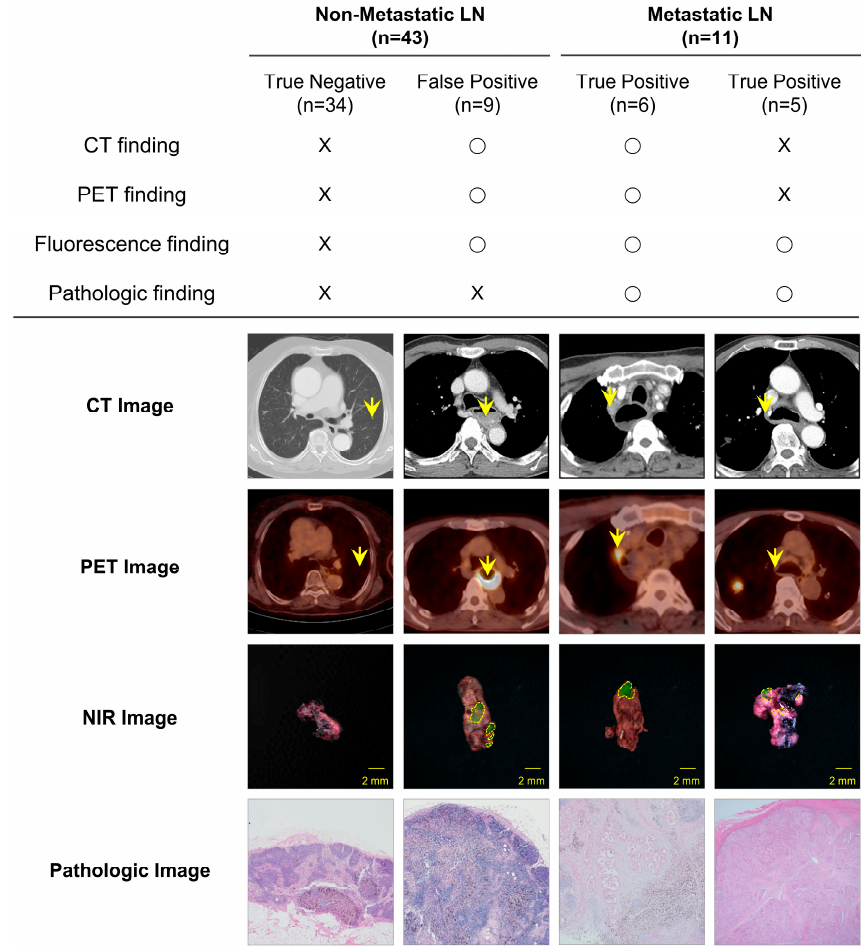
Figure 3. Comparison of the detection efficiencies of CT, PET/CT, and ICG imaging for LNs in patients. Representative CT, PET/CT, NIR (green) fluorescence, and pathological images of patients. The patients were classified into two groups (nonmetastatic and metastatic LNs) based on the pathologic results. The yellow arrows indicate metastatic LNs, “O” indicates the presence of metastasis, and “X” indicates the absence of metastasis. CT, computed tomography; PET/CT, positron-emission tomography/computed tomography; NIR, near-infrared; LN, lymph node.